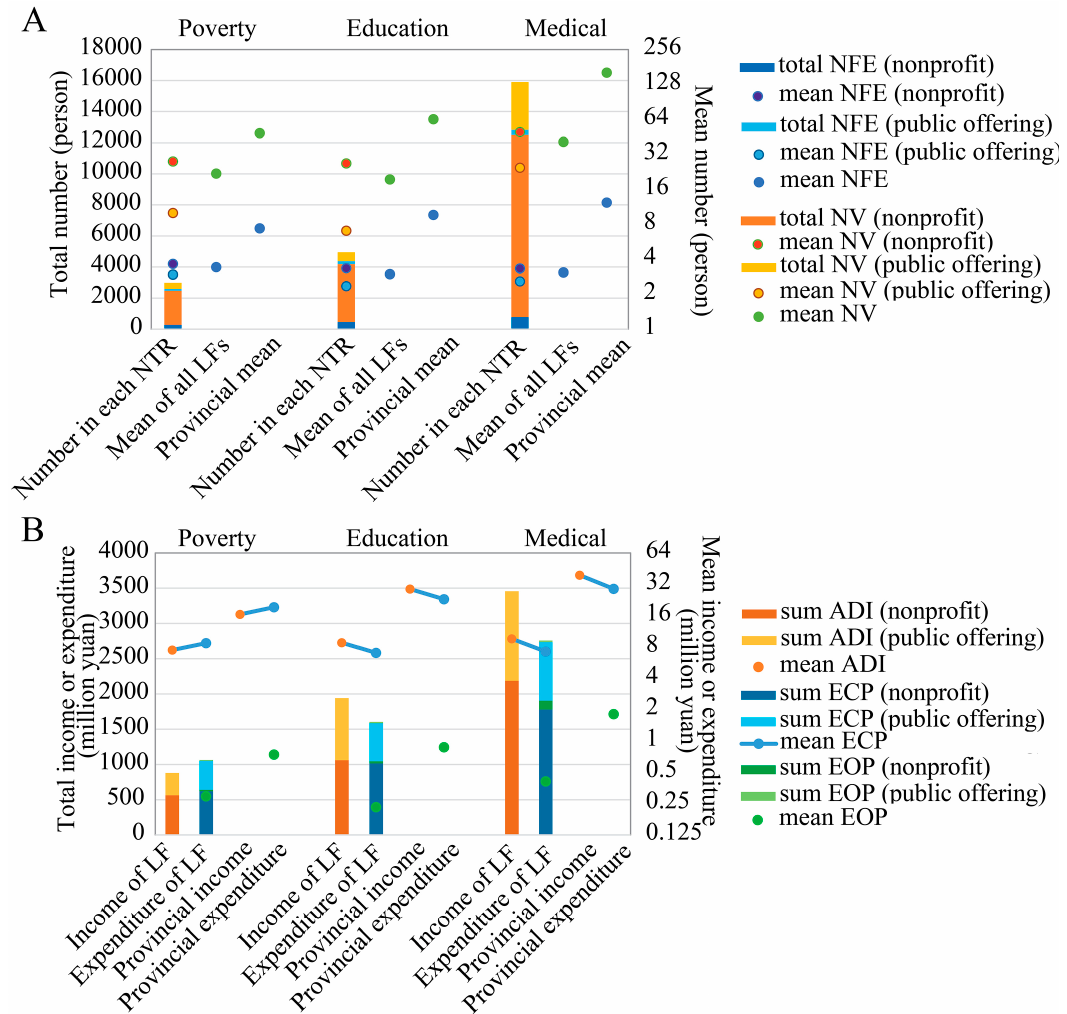
Figure 3. Statistical summary of the employee and volunteer numbers ( A ) and the incomes and expenditures ( B ) of local foundations.